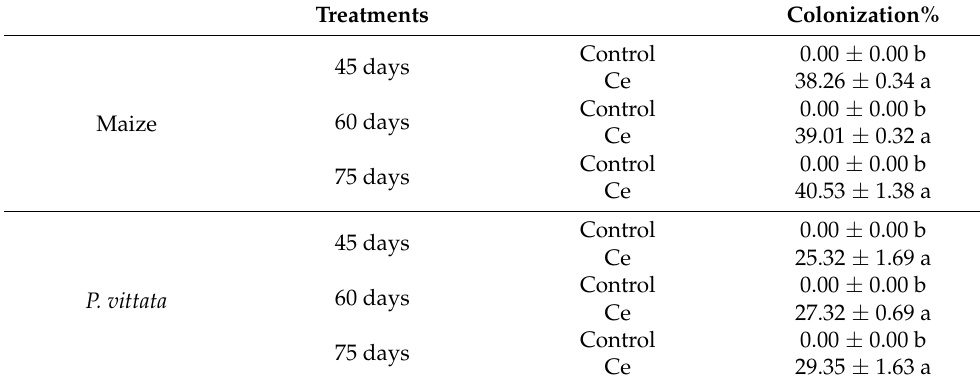
Table 1. Effects of colonization by Ce on the mycorrhizal colonization rate of maize and P. vittat under arsenic stress in different